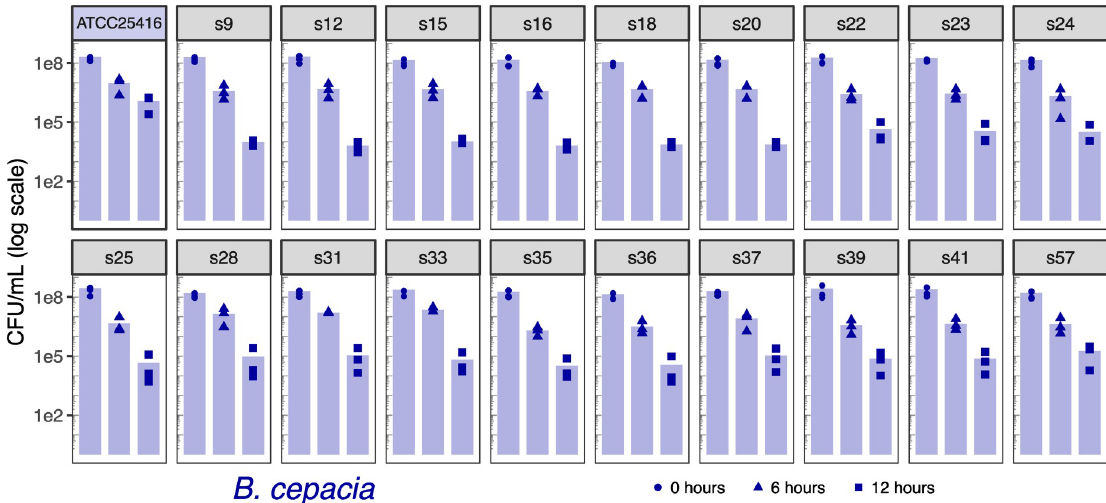
Fig 6. B . cepacia colony forming units per milliliter (CFU/mL) following addition of J774A.1 mouse macrophage. Hours indicate time from addition. Decreased counts are assumed to be due to the cells’ increased propensity for macrophage lysis over time. As compared to the reference strain via two-sided t-tests, none were found to have an adjusted p-value < 1 (adjusted by Bonferonni correction). Bars depict means, all points are plotted (n =